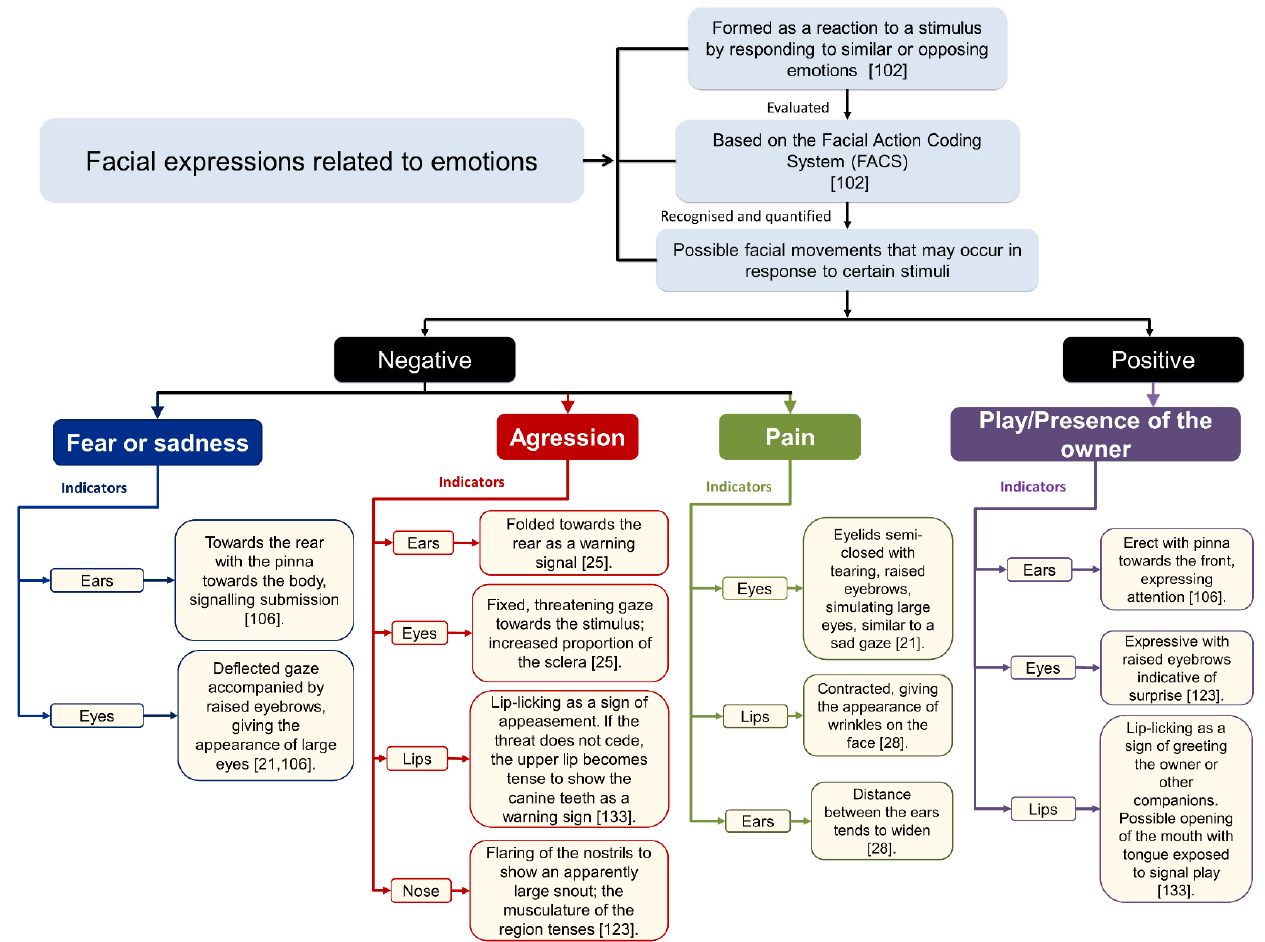
Figure 9. Facial expressions related to emotions [21,25,28,106,123,133]. Behavioral evaluations of pain must consider several indicators. In dogs, Camps et al. [146] described the principal characteristics of aggression related to pain. They affirm that behavioral changes are the most common indicator of pain manifested by this species through such behaviors as aggression, fear, vocalizations, reduced interaction with conspecifics or family members, and altered postures or facial expressions, restlessness, and concealment (Figure 10).